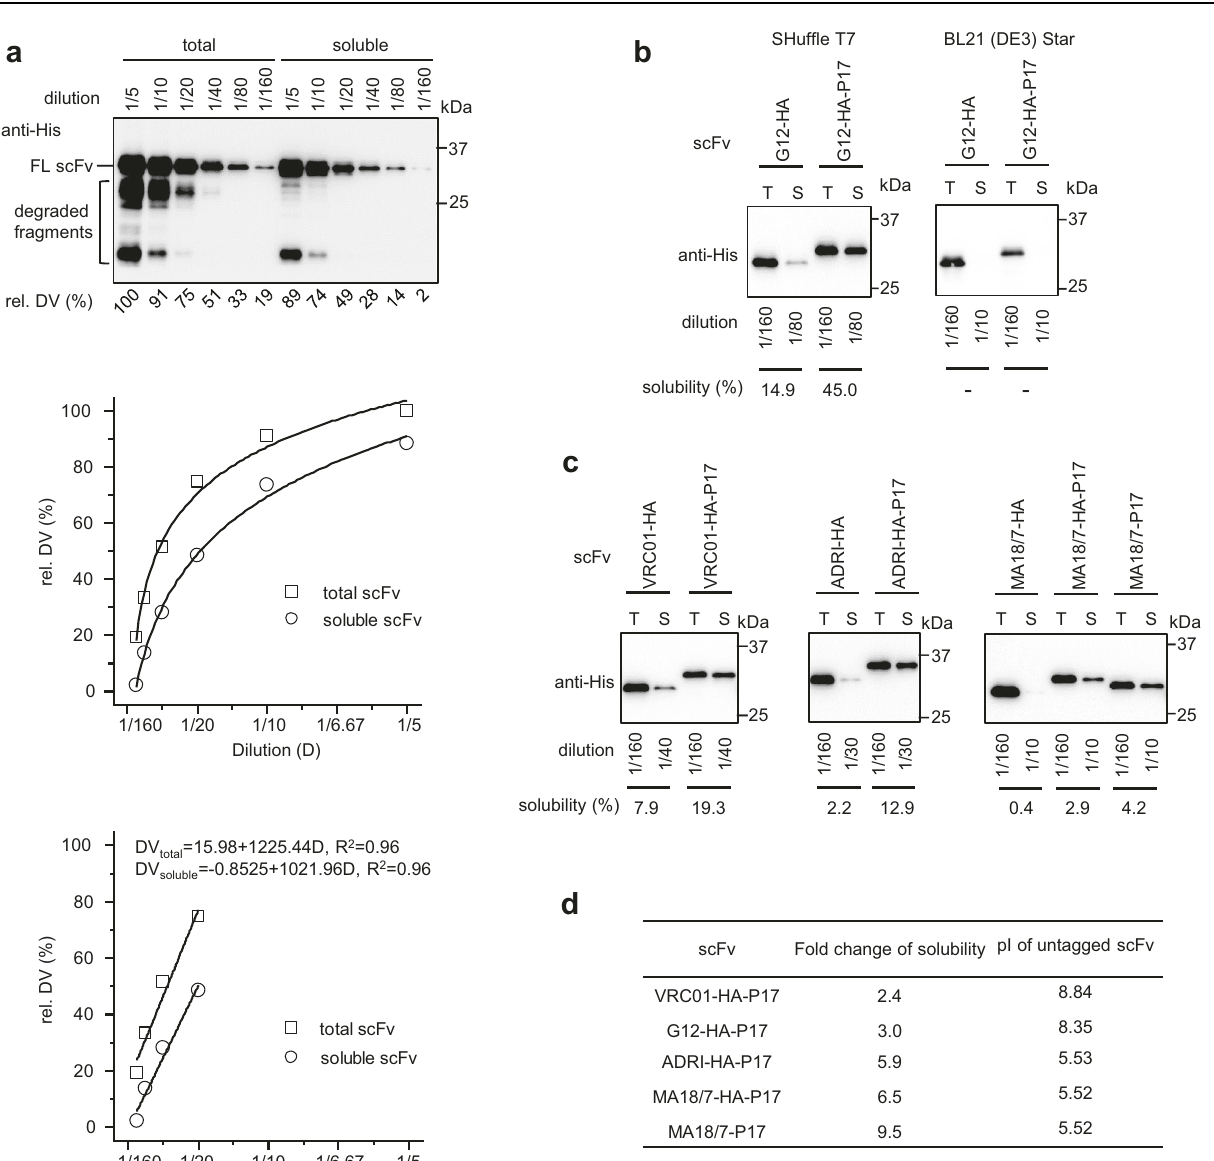
of Origin 8.0. Linear equations of rel. DV and dilution (D) are also presented. b Determination of solubility of G12-scFv-HA and G12-scFv-HA-P17